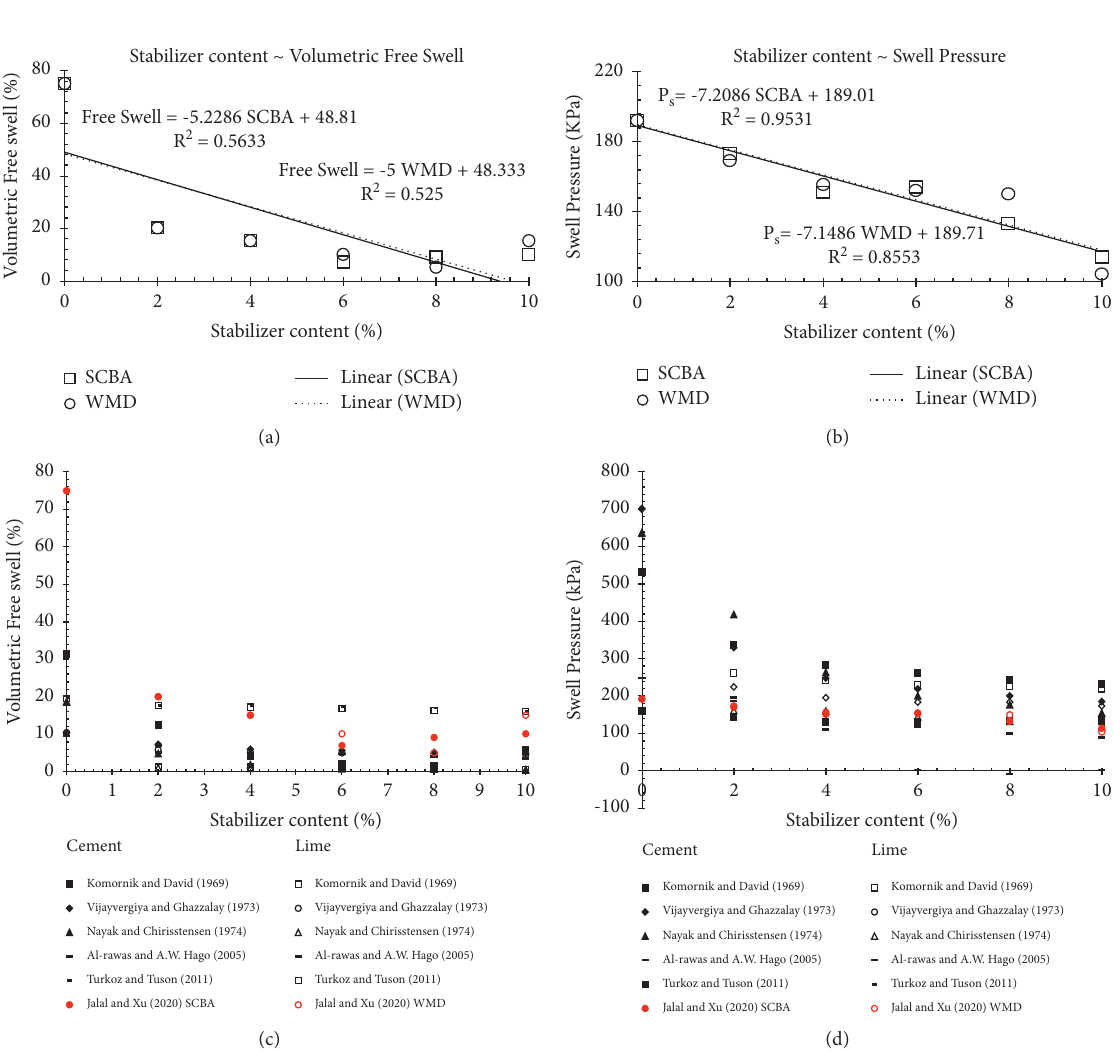
Figure 9: Comparison of swell potential results with previous results (volumetric free swell and swell pressure) upon addition of SCBA and WMD.